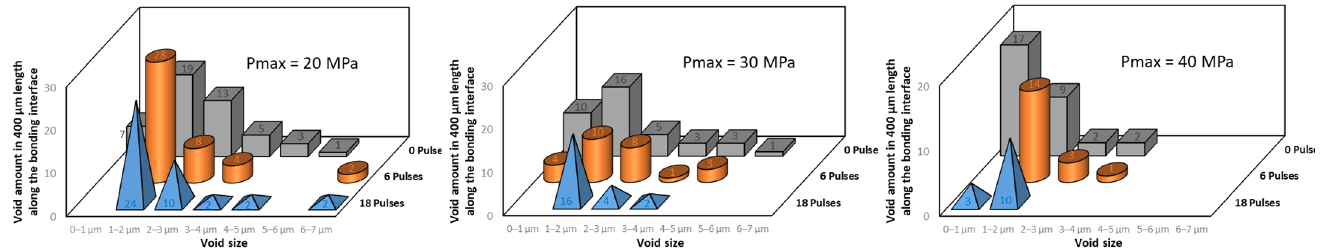
Figure 4. Influence of maximum pressure (Pmax = 20, 30, and 40 MPa) and number of pulses (0, 6, and 18) on the number and size of voids along the bonding interface of ferritic stainless steel samples produced by IPADB after data from Sharma and Dwivedi [37].